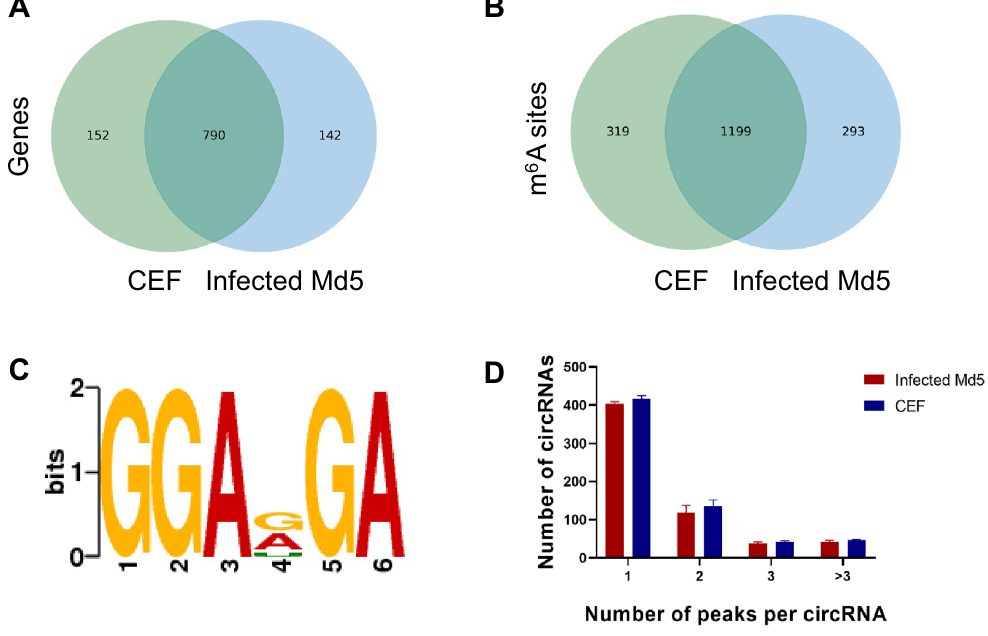
Figure 3. The characteristics of m 6 A peaks. ( A ) Venn diagram of m 6 A genes in infected Md5 and CEF groups; ( B ) Venn diagram of m 6 A methylation sites identified in circRNAs from infected and CEF groups; ( C ) The sequence motif of m6A sites in infected and control groups (Made by Discriminative Regular Expression Motif Elicitation (DREME), v5.3.3, https:// meme- suite. org/ meme/ tools/ dreme); ( D ) Proportion of genes harboring different numbers of m 6 A sites in the two groups (Made by Prism, v8.0.2, https:// www. graph pad.